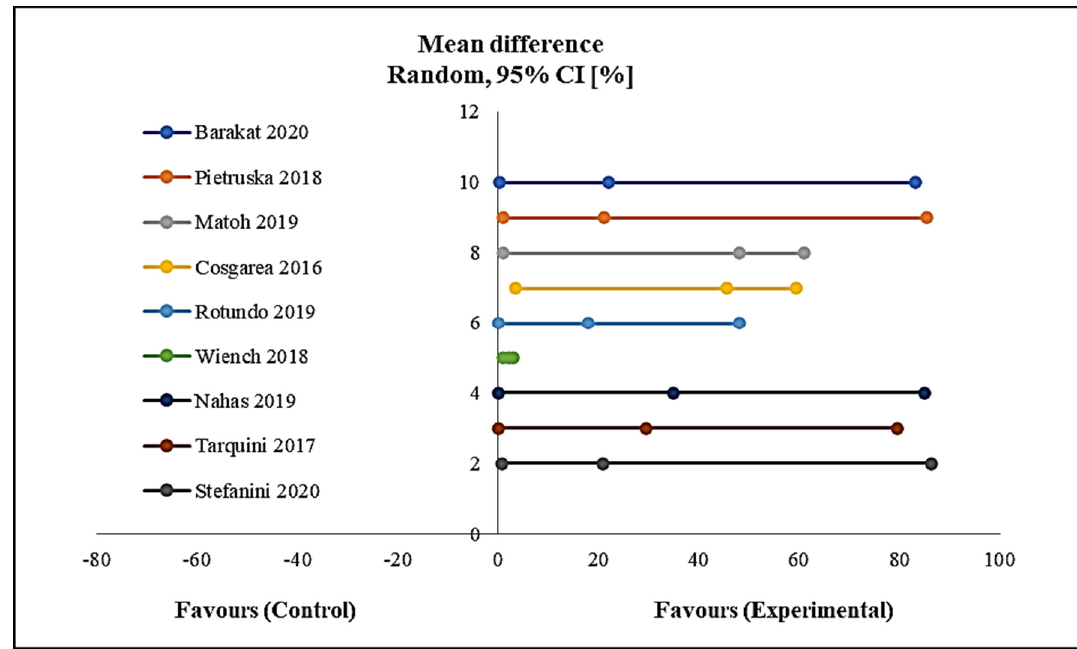
Figure 7. Forest plot shows mean % of mean root coverage.